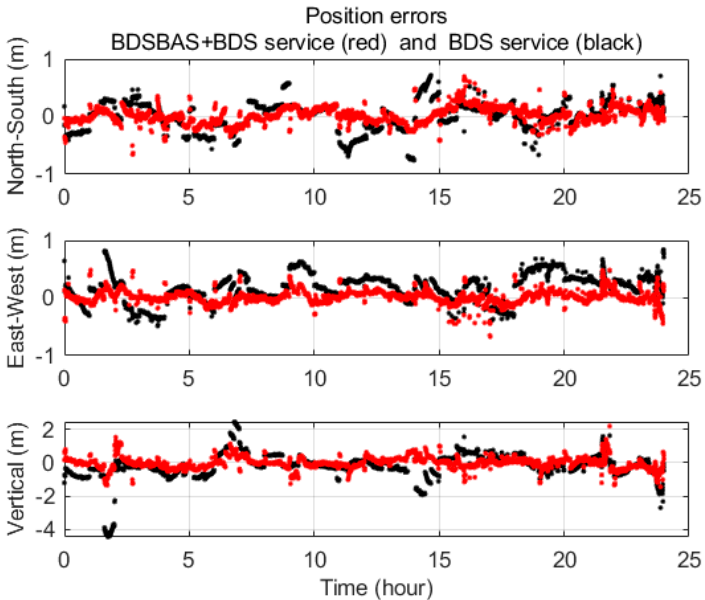
Figure 6. Comparison of position errors between the BDSBAS DFMC service (red lines) and the BDS dual-frequency service (black lines).